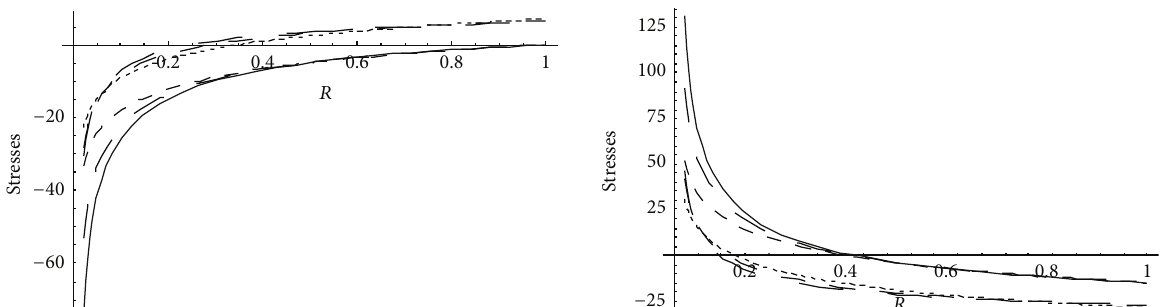
Figure 7: Homogeneous transitional stresses for a thick-walled circular cylinder under internal ( 𝑃 1 = 5 ) and external pressure ( 𝑃 2 = 0 and 15).